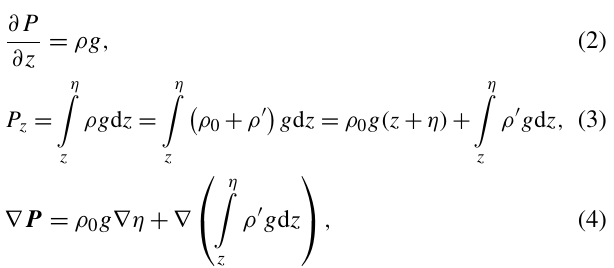
Figure 4. Validations of the wintertime TWC fluctuations: (a) ob- served alongshore currents, (b) simulated alongshore currents, (c) observed cross-shore currents and (d) simulated cross-shore cur- rents. The observation data come from station 4 in Fig. 1 and the simulated data have the same position and period as the observation data.